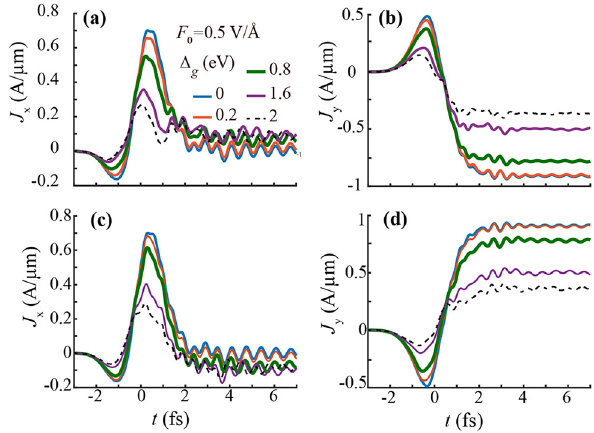
Figure 3: Currents J x [panel (a)] and J y [panel (b)] excited by a left-hand circularly polarized pulse with the amplitude of = 0 . 5 V ̊ A − 1 . The corresponding band gaps are marked in panel F 0 (a). In panels (c) and (d) the GG is excited by a right-hand circularly polarized pulse.